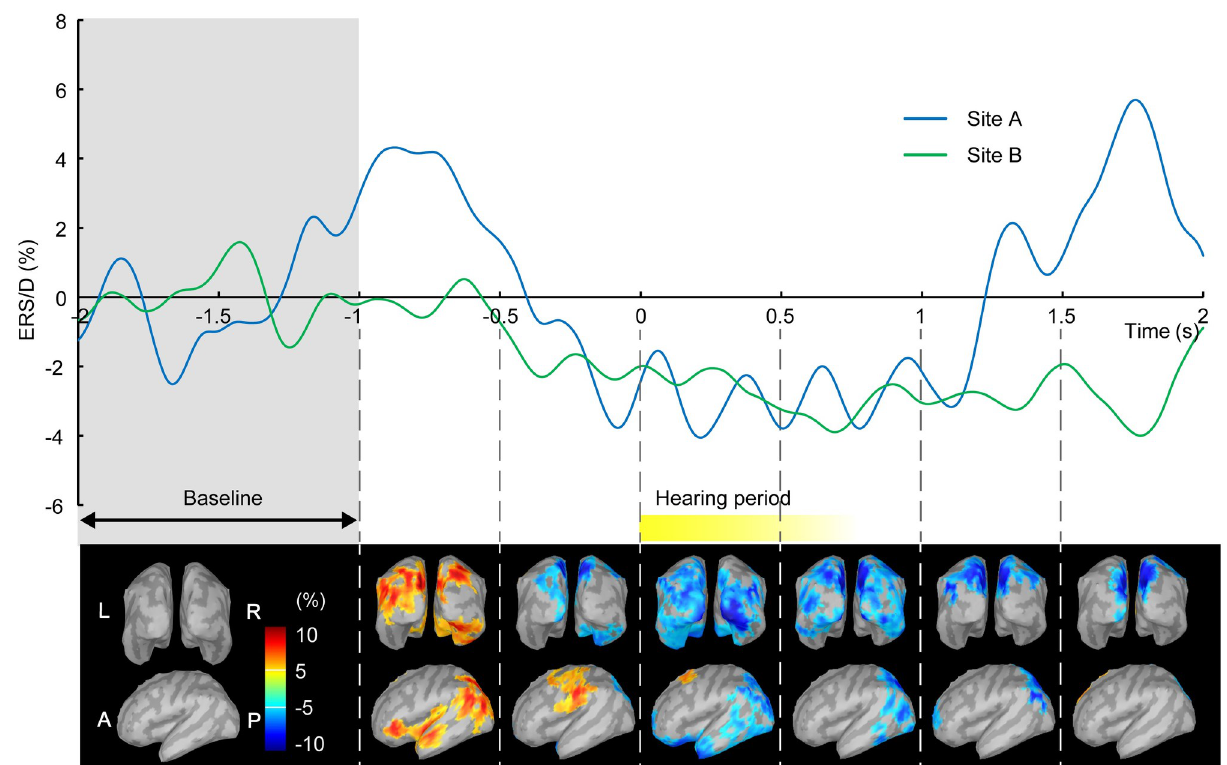
Fig 3. Amplitude modulation of alpha-band rhythm during face-to-face conversation. redThe brain responses when two subjects faced each other via the A/V devices and spoke words in turns are shown. Mean alpha rhythm amplitude across 128 speech exchanges was normalized by the mean amplitude over the baseline period, from -2 and -1 s, to calculate Event Related Synchronization (ERS) and Event Related Desynchronization (ERD). The time traces of ERS/D averaged over the whole brain of each subject at site A (blue line) and B (green line) are shown on the upper panel. The brain activity of the subjects at both sites reflects that which is associated with listening, with time point 0 ms being the moment of speech onset of the opposite party. ERD of alpha rhythm is exhibited just before and during hearing the speech (mean: 0.7 s) of the opposite party. The brain surface images on the lower part show mean distributions of ERS (red; < +5%) and ERD (blue; > -5%) on each of the 15,002 vertices across both subjects; back-view (upper row) and left side-view (lower row). This mean alpha rhythm ERS/D was furthermore averaged temporally within each 0.5 s bin. A distinct ERD in the bilateral occipital region (visual area) and left temporal region (linguistic area) observed after 0 s indicate functional involvement of both the visual and auditory systems, suggesting that each subject could visually predict the onset of the opposite party’s speech. Abbreviations. L: Left, R: Right, A: Anterior, P: